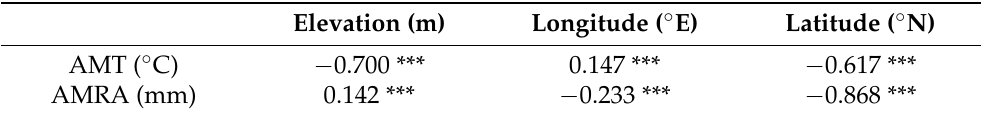
Table 5. Correlation coefficient between the AMT and AMRA and various geographical factors in the QMs during the period from